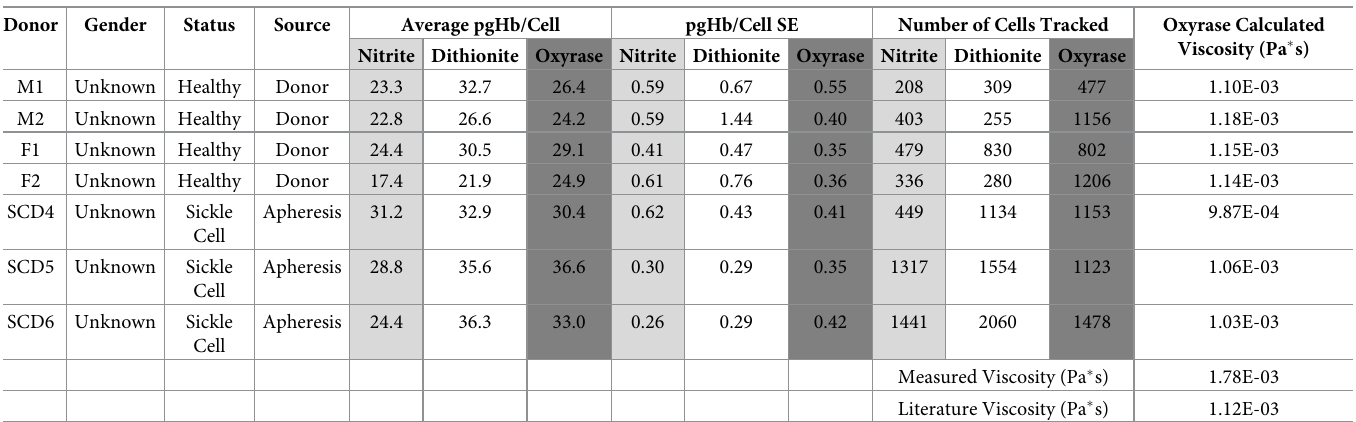
Table 1. Intracellular hemoglobin and experimental viscosities.